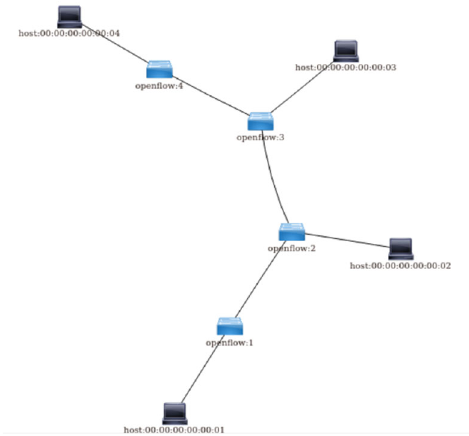
Figure 24. Diagrammatically create custom linear network topology on ODL DLUX console.